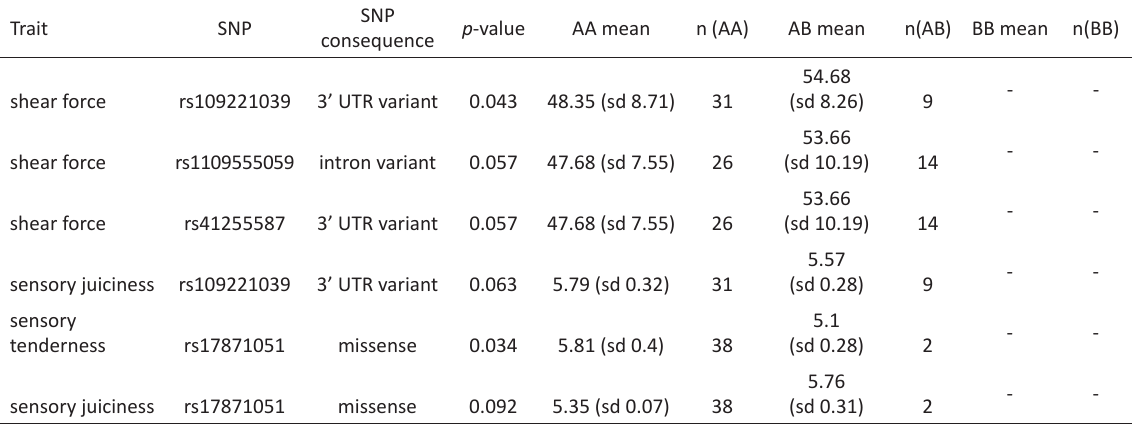
229beneficial Table 2. Meat quality traits for FAA showing differences ( p -value <0.1) with CAPN1 and CAST gene variations Trait SNP sensory tenderness Table 3. Meat quality traits for NRC showing differences ( p -value <0.1) with CAPN1 and CAST gene variations Trait SNP color